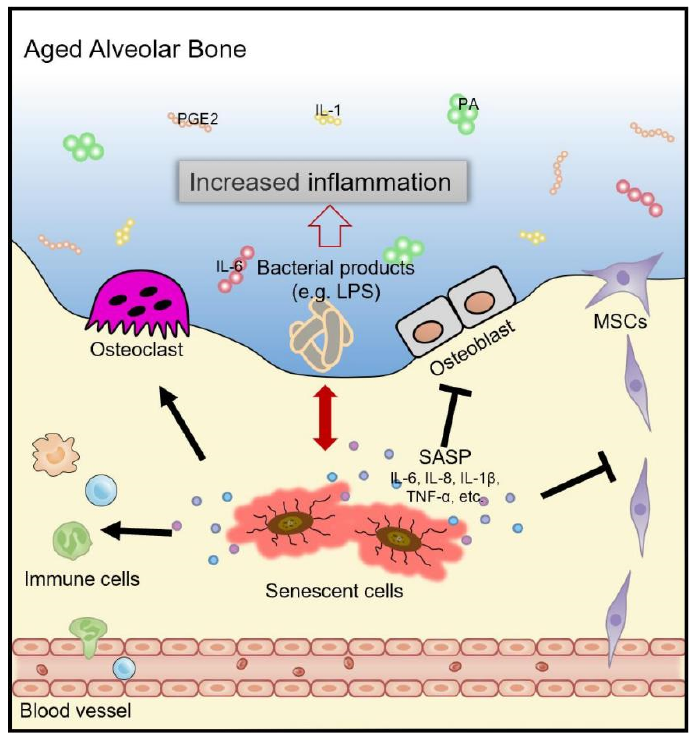
Figure 1. Mechanisms underlying excessive alveolar bone loss in periodontitis with aging. Due to advancing age or long-term exposure to bacterial products (e.g., LPS), the senescent osteocytes accumulate in the alveolar bone and develop a proinflammatory SASP (IL-6, IL-8, IL-1 β , TNF- α , etc.), which can exacerbate the chronic inflammation of periodontal tissue. Pro-inflammatory cytokines and matrix-degrading enzymes secreted by senescent cells can damage the local microenvironment and induce bystander effects in neighboring cells. Owing to intrinsic senescence and the aging microenvironment, the dysregulation of immune responses may lead to the chronic persistence of pathogens and increased accumulation of immune cells in the periodontal tissues. Consequently, the homeostasis between osteoblasts and osteoclasts is disrupted, and the immunomodulatory effects, migratory ability and differentiation potential of MSCs are impaired, both of which lead to defective alveolar bone regeneration. All of these factors could result in more alveolar bone loss in periodontitis with